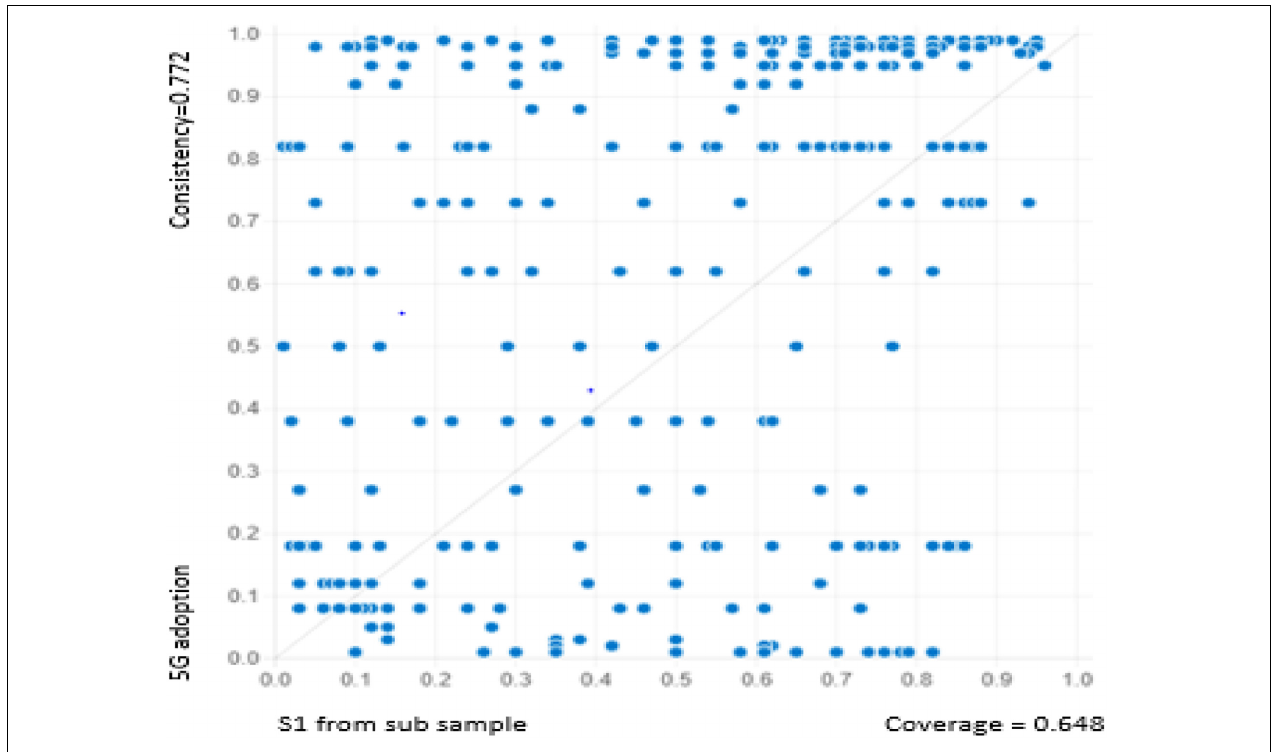
FIGURE 3 | Fuzzy-plot of solution 1 ( Table 10 ) using holdout dataset.